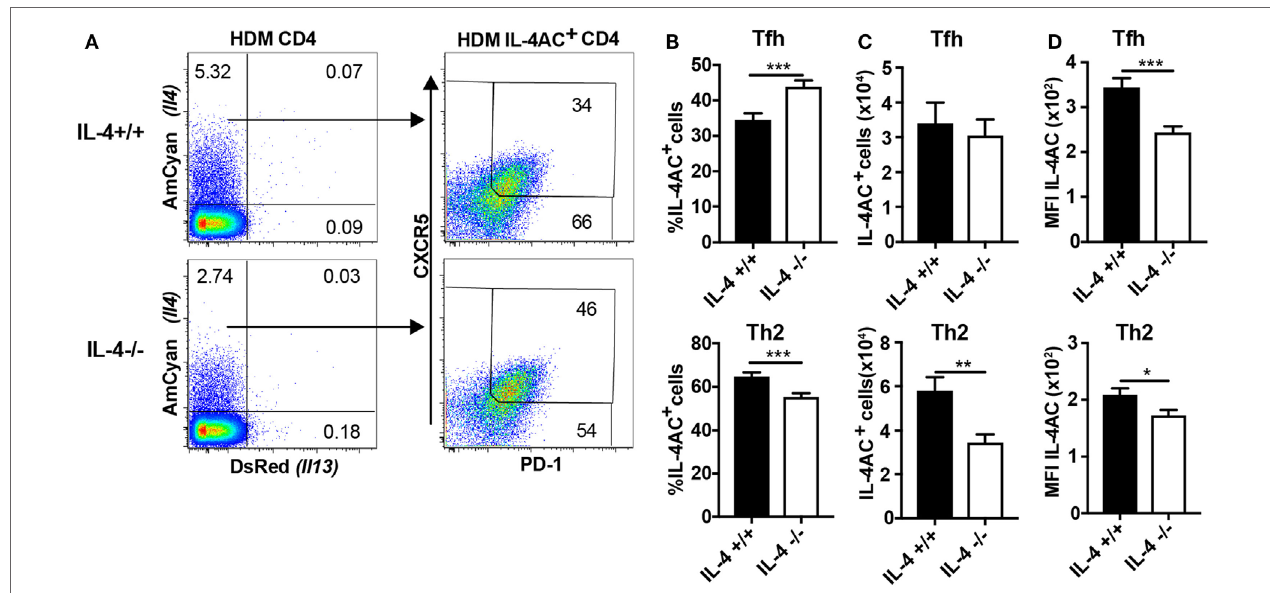
FigUre 3 | IL-4 plays a role in the development of IL-4AC-expressing lymph node Th2 cells but not IL-4AC-expressing T follicular helper (Tfh) cells. 4C13R-IL-4 + / + and 4C13R-IL-4 − / − mice were treated with 200 μ g house dust mite (HDM) i.d. in the ear. The ear draining lymph nodes were harvested from mice 7 days posttreatment, and lymph nodes were analyzed by flow cytometry. (a) FACS plots showing the proportion of IL-4AC + CD4 T cells and then the proportion of CXCR5 + PD-1 + Tfh and CXCR5 lo PD-1 lo , CXCR5 + PD-1 lo , and CXCR5 lo PD-1 + Th2 cells within this population. (B) Proportion of IL-4AC + CD4 T cells that are Tfh or Th2 cells. (c) Numbers of IL-4AC + Tfh and IL-4AC + Th2 CD4 T cells and (D) median fluorescent intensity (MFI) of IL-4AC of IL-4AC + Tfh and IL-4AC + Th2 CD4 T cells. (a) FACS plots from a representative experiment ( n = 6). (B,c) Data pooled from three experiments ( n = 18). (D) Data from a representative experiment ( n = 6). Data show mean + SEM (* p ≤ 0.05, ** p ≤ 0.01, and *** p ≤ 0.001 two-tailed t